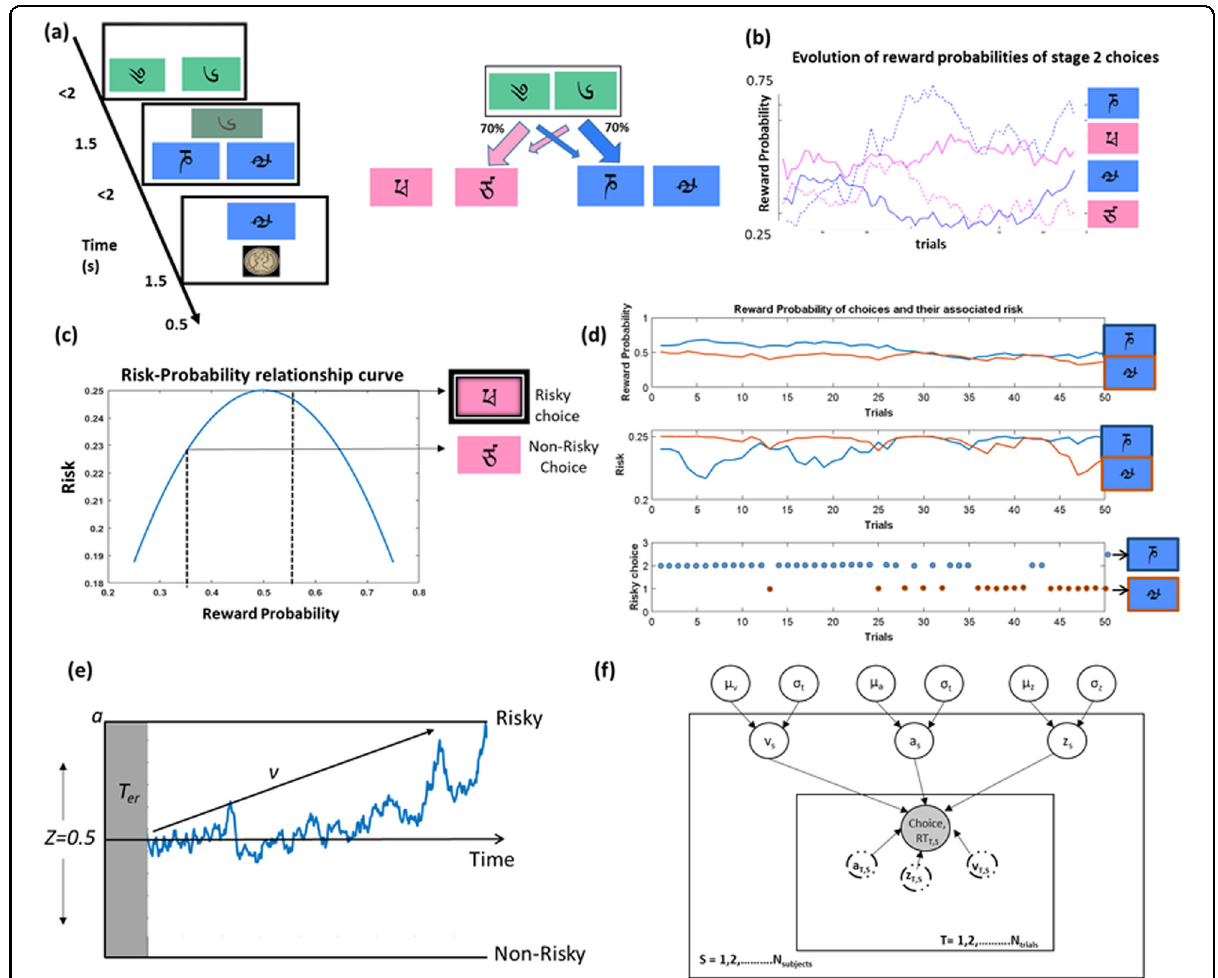
Fig. 1 Sequential learning task, risk-probability formulation and hierarchical drift – diffusion model(HDDM) ( a ) 2-step sequential learning task ( b ) Evolution of all stage 2 choice reward probabilities across trials ( c ) risk/uncertainty as a function of second stage reward probability (Eq. 1) which follows an inverted U-curve ( d ) An example plot with reward probabilities of two stage2 choices, their corresponding risk(Eq. 1) and trial-wise risky choice among the two choices ( e ) pictorial representation of the drift – diffusion model with its parameters (threshold — a , drift rate- v and response bias- z ) and ( f ) pictorial representation of the HDDM structure with input variables and